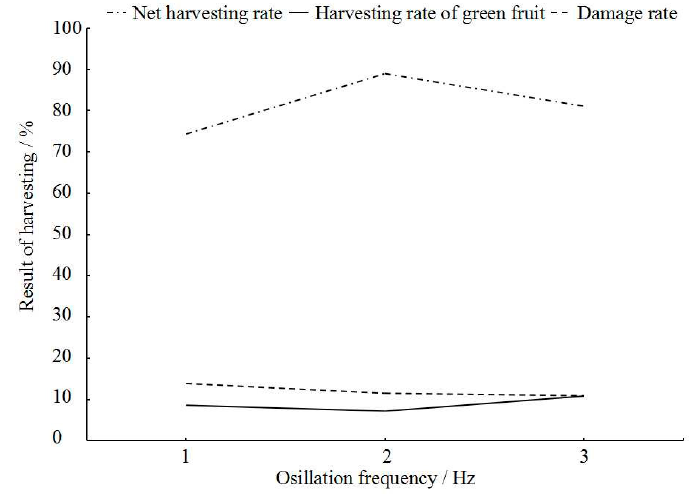
Figure 8. Effects of oscillation frequency on different parameters.